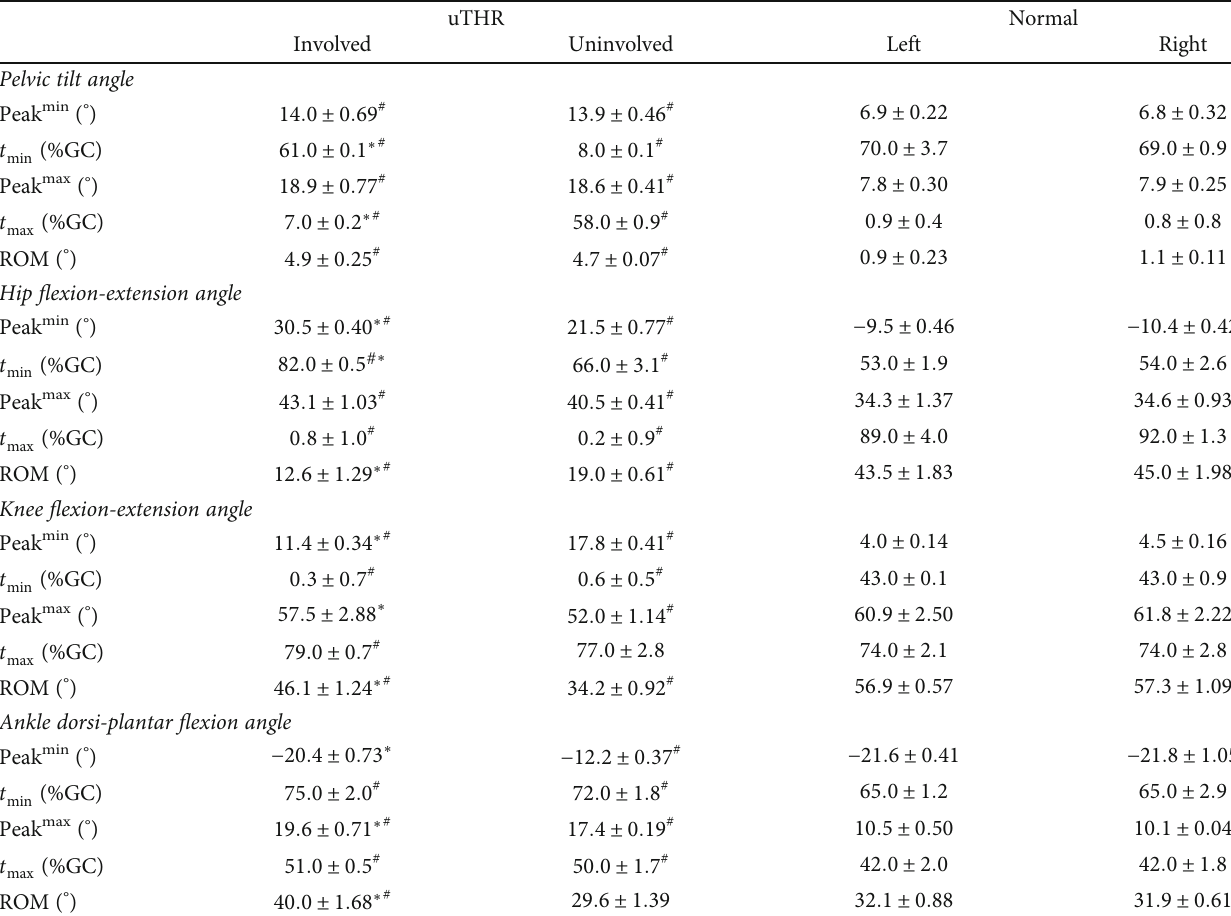
Table 1: Mean ± standard deviation for the range of motion (ROM) for the uTHR and normal groups. uTHR Normal Involved Uninvolved Left Right Pelvic tilt